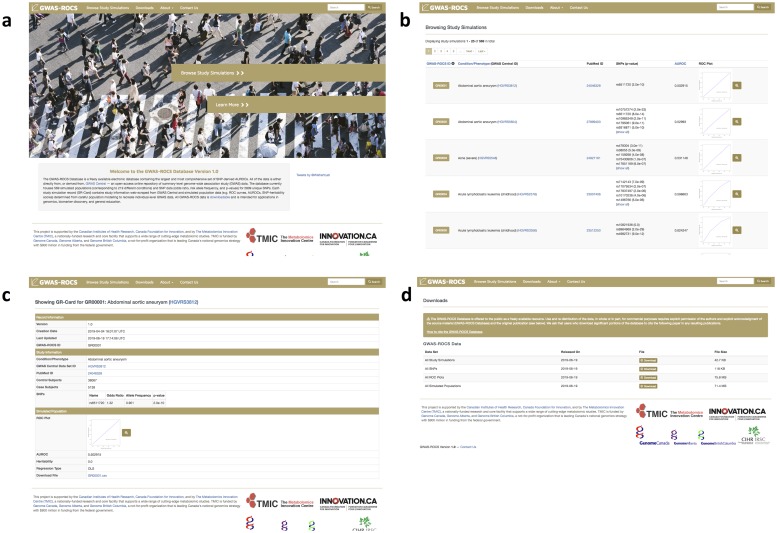
A screenshot montage of the GWAS-ROCS database at http://gwasrocs.ca.a) The landing page. b) Browse Study Simulations tab. c) Study simulation page. d) Downloads tab.